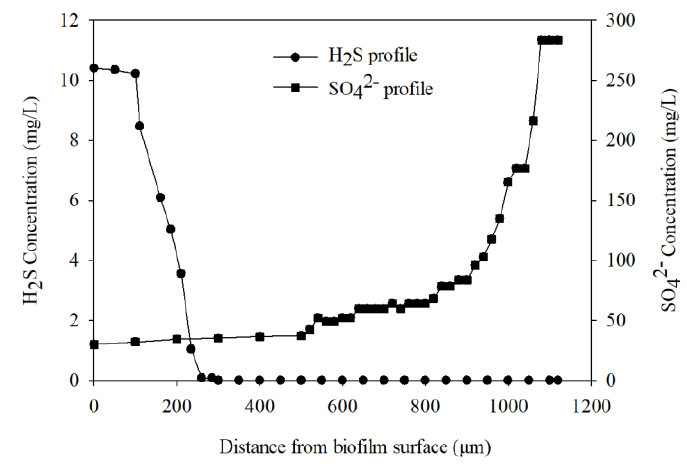
42 − microelectrode profiles within the Figure 5. H 2 S and SO 42− microelectrode profiles within the biofilm. Figure 5. H 2 S and SO